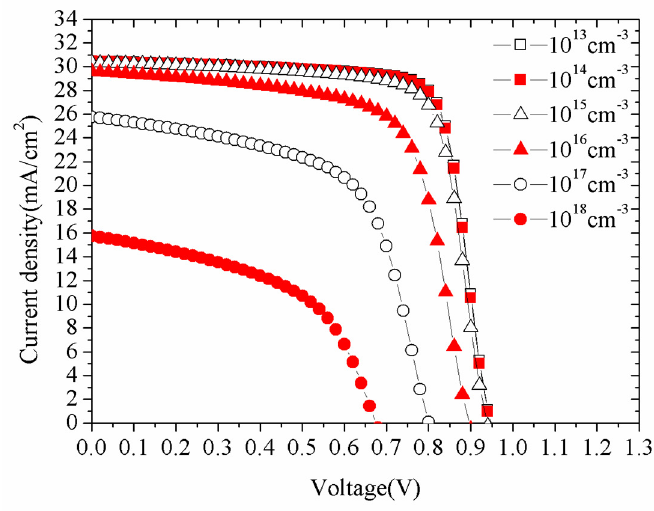
Figure 9. E ff ect of absorber layer defect density on J-V Figure 9. Effect of absorber layer defect density on J-V characteristics.